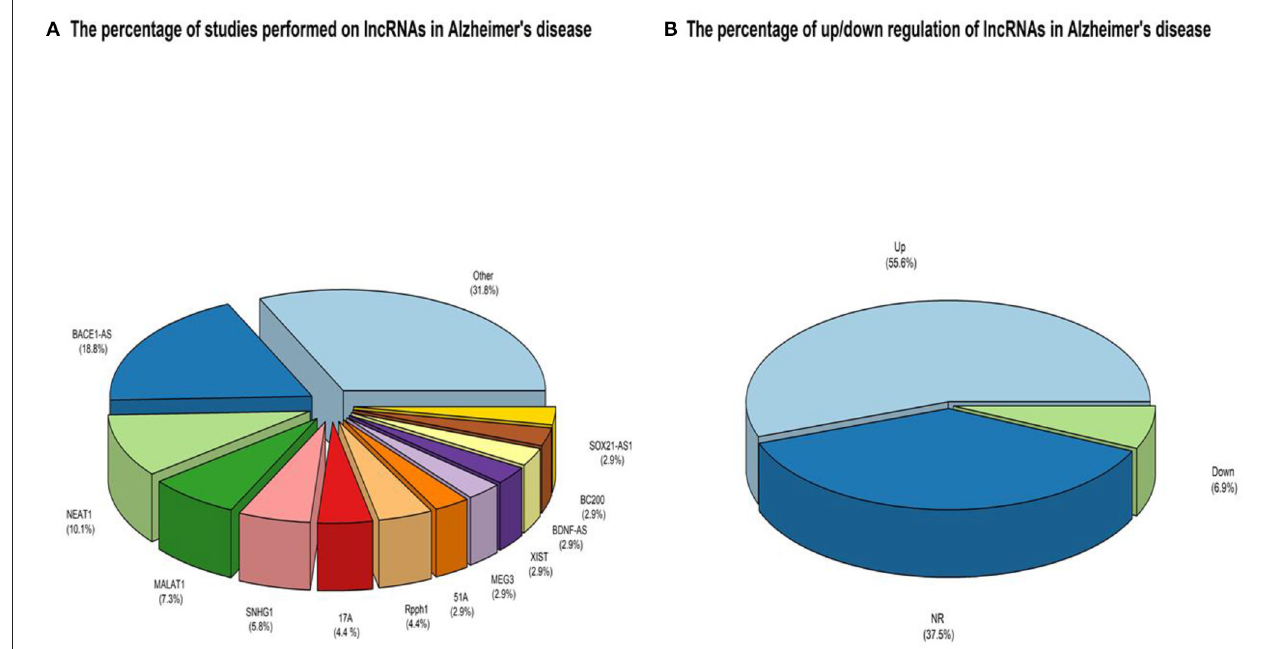
FIGURE 2 | (A) An overview of the LncRNAs proportion is considered in the qualified studies. The other part is about lncRNAs that have only been studied once that can be accessed by referring to Table 3 . (B) An overview of the ratio of up-regulated LncRNAs compared to down-regulated ones. NR also reflects non-reported studies of regulation